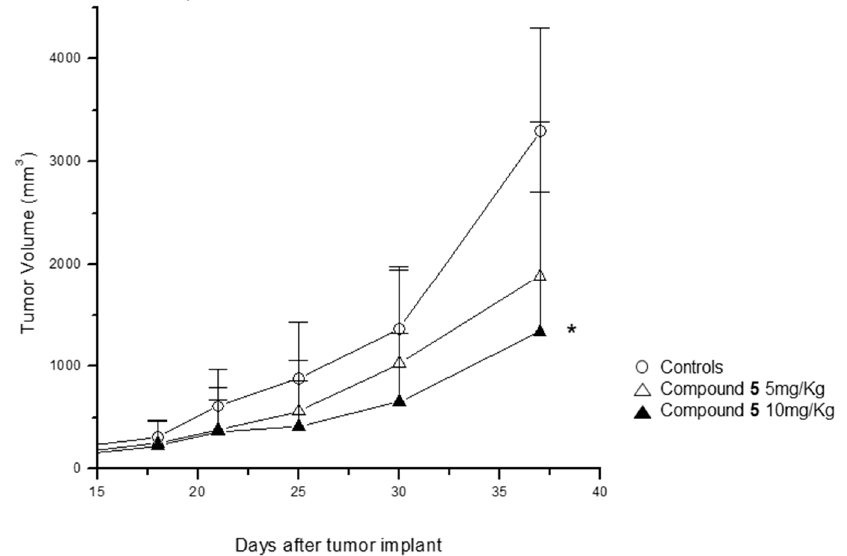
Figure 6. Antitumor activity of compound 5 in A431 squamous cell carcinoma xenografts in nude mice. Compound 5 dissolved in physiologic saline was administered i.p. (5 mg/kg and 10 mg/kg) for five consecutive days/week. The treatment started when the tumors were just palpable and was repeated for three weeks.